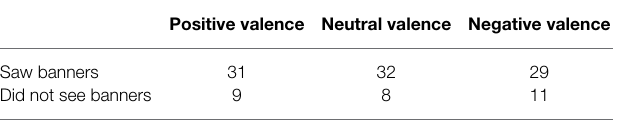
TABLE 7 | Summary table of found and missed banner with positive, neutral, and negative valence.